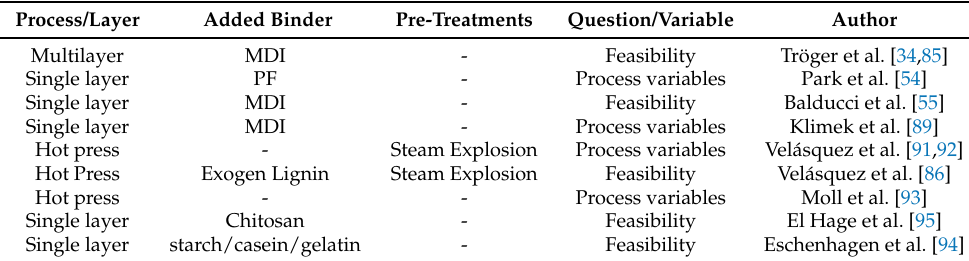
Table 2. An overviewof different projects describing Miscanthus based board or insulation